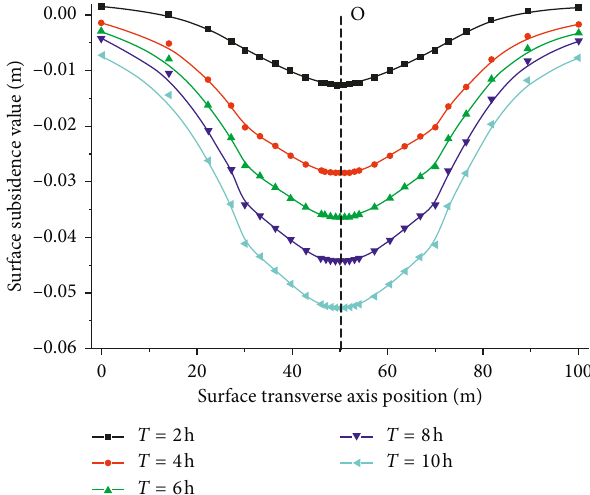
Figure 21: Schematic diagram of the surface settling tank with reinforcement depth of H � 19m.